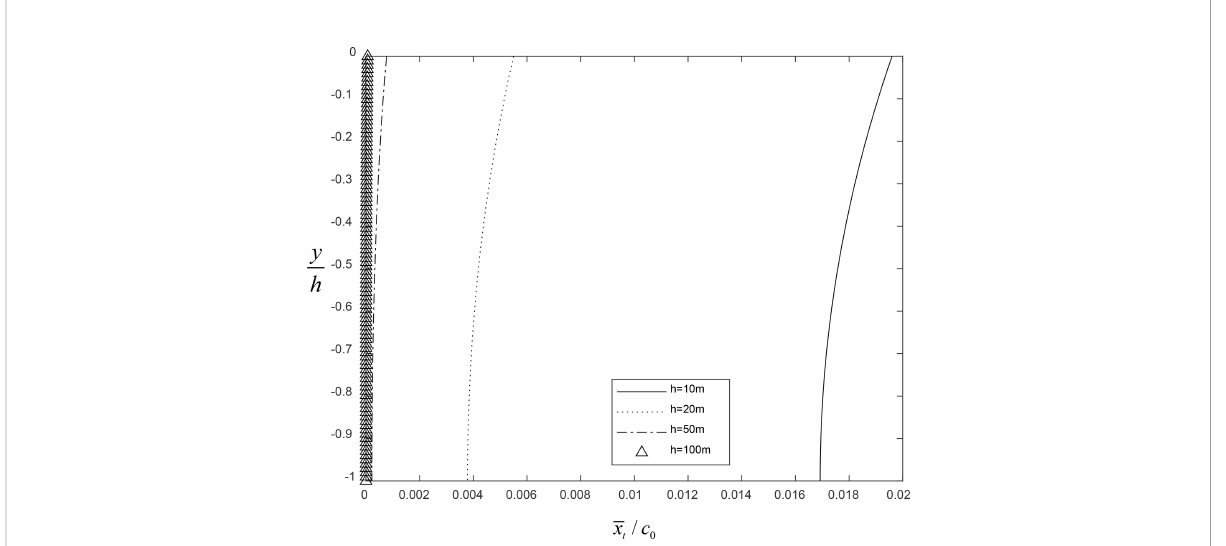
FIGURE 4 Dimensionless mass transport velocity versus vertical labels b for the thickness of the ice sheet d = 1 m under various water depths h = 10, 20, 50, 100 m.